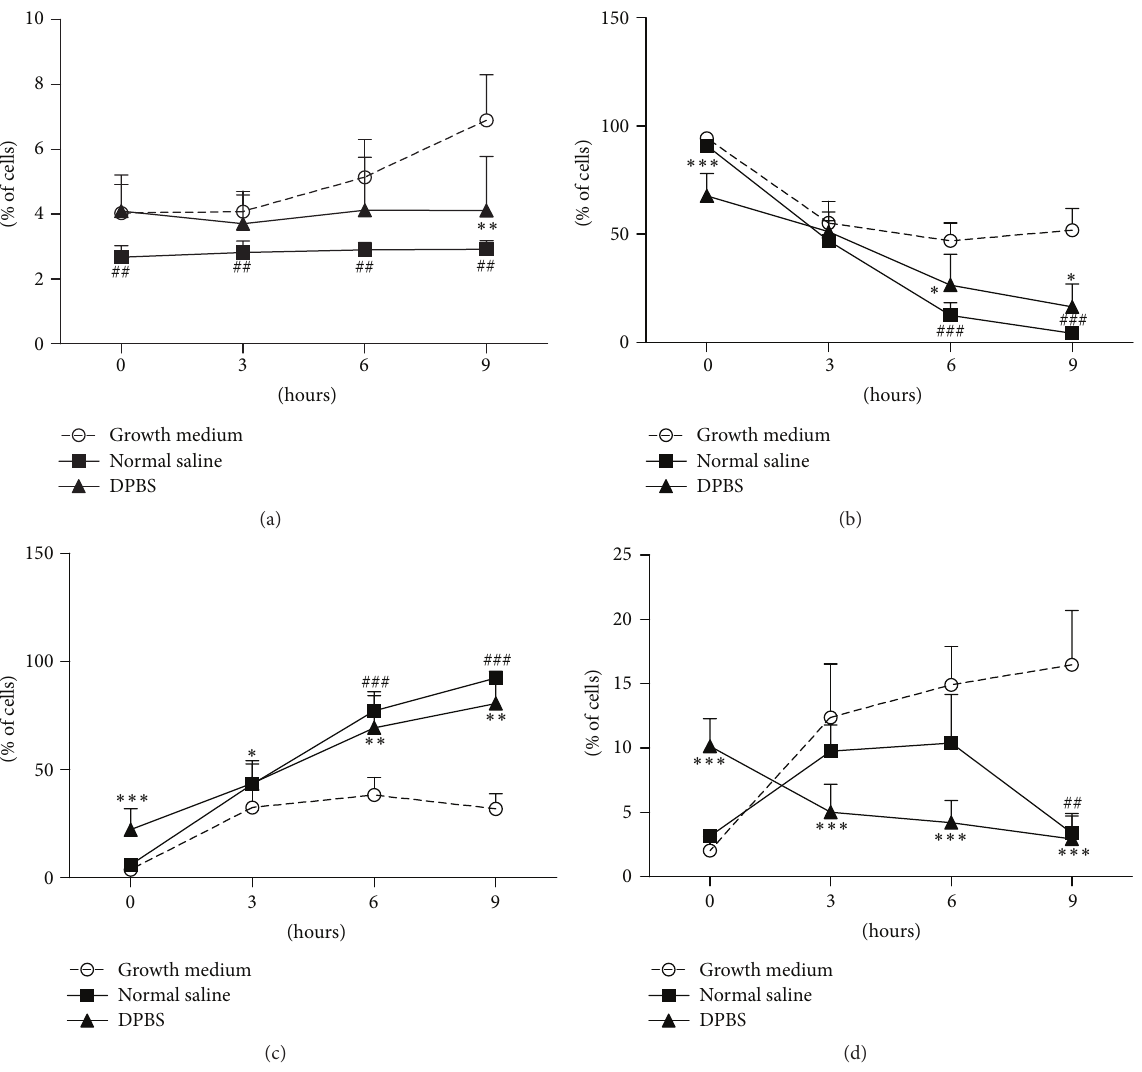
Figure 4: Effects of storage solution and storage time on cell clumping and viability before transplantation. Fresh passage 5 rat BMMSCs were resuspended in complete growth medium, normal saline, and DPBS and stored at 37 ∘ C for 3h, 6 h, and 9 h before analysis. (a) Cell clumps or large cells > 30 𝜇 m; (b) viable cells; (c) dead cells; (d) apoptotic cells. ## 𝑃 < 0.01 normal saline versus growth medium. ### 𝑃 < 0.001 normal saline versus growth medium. ∗ 𝑃 < 0.05 DPBS versus growth medium; ∗∗ 𝑃 < 0.01 DPBS versus growth medium; ∗∗∗ 𝑃 < 0.001 DPBS versus growth